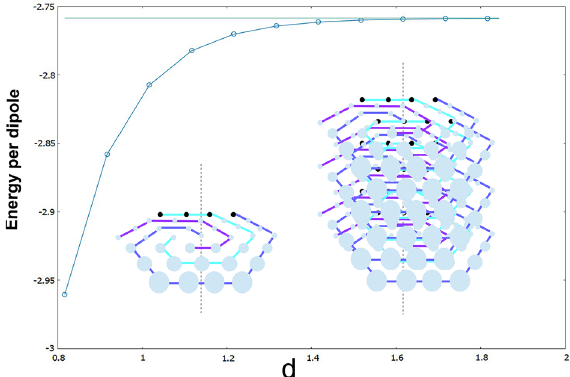
Figure 7. Plot of the evolution of the energy per particle in the thermodynamic limit as a function of the vertical cell distance d , for the hcp lattice. The horizontal line corresponds to the asymptotic d particle value of the vortex state. See text for